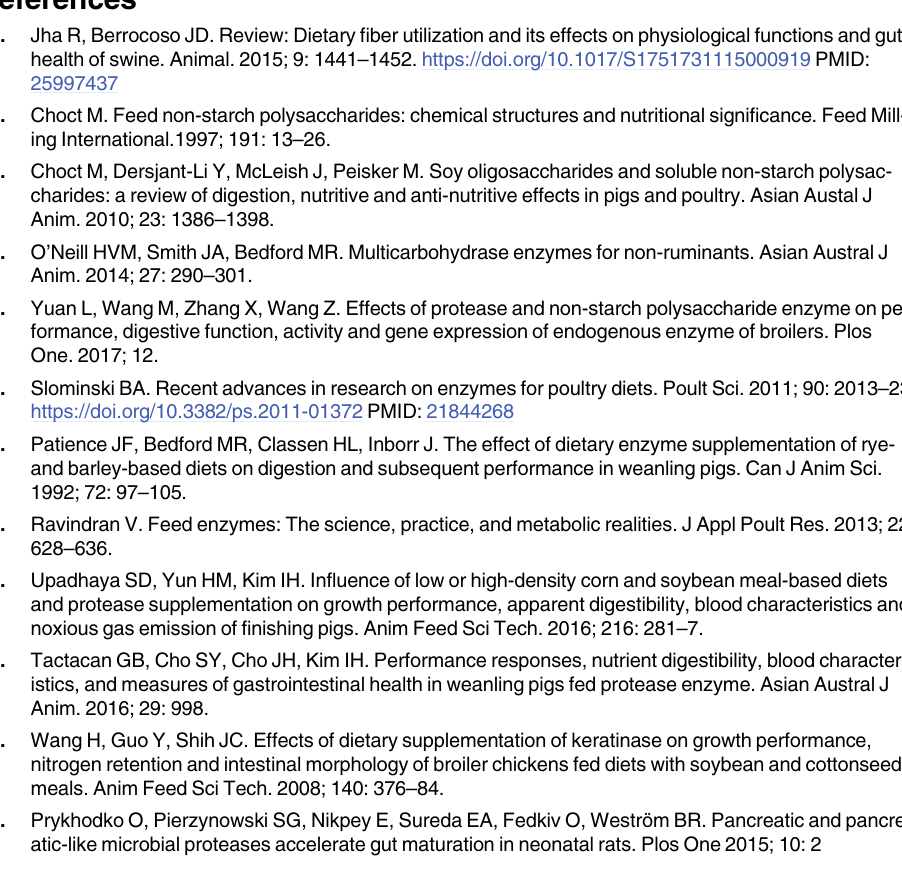
S2 Table. Relative abundance of taxa in control and treatment groups representing > 0.1% of total